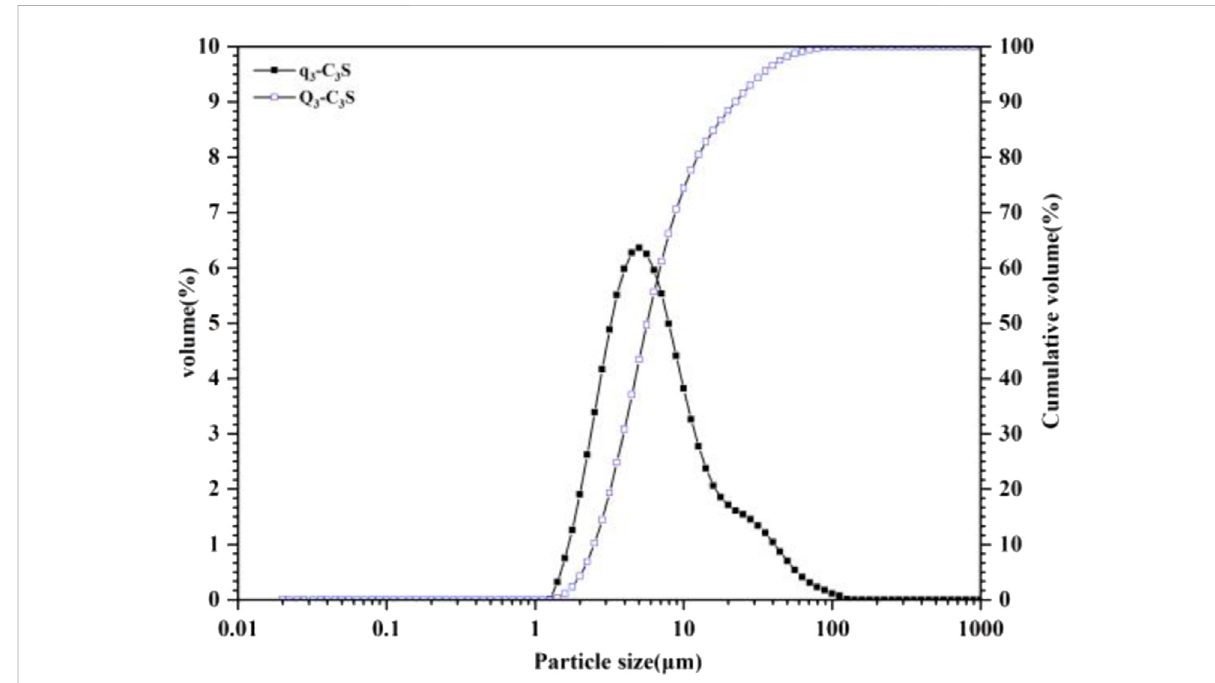
FIGURE 3 Particle size distribution of C 3 S single-phase raw